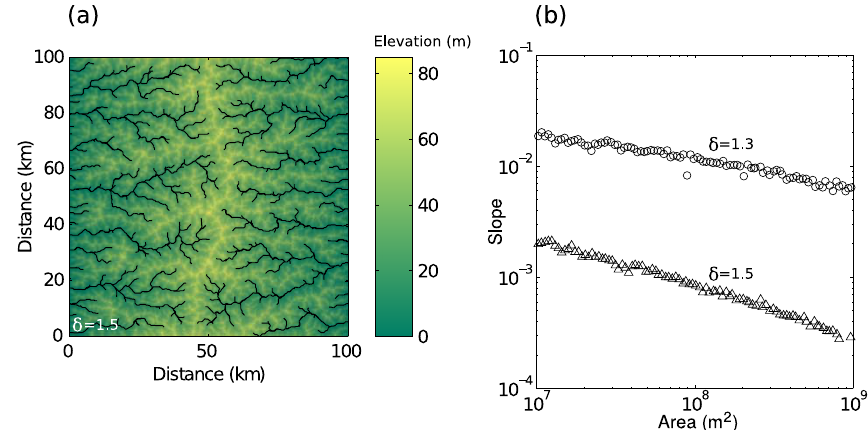
Figure 3. (a) Steady-state topography after 10Myr for the transport model in which δ = 1 . 5 and c = 10 − 4 (m 2 yr − 1 ) 1 − δ . (b) Slope–area relationship for the transport model for δ = 1 . 3 and δ = 1 . 5.